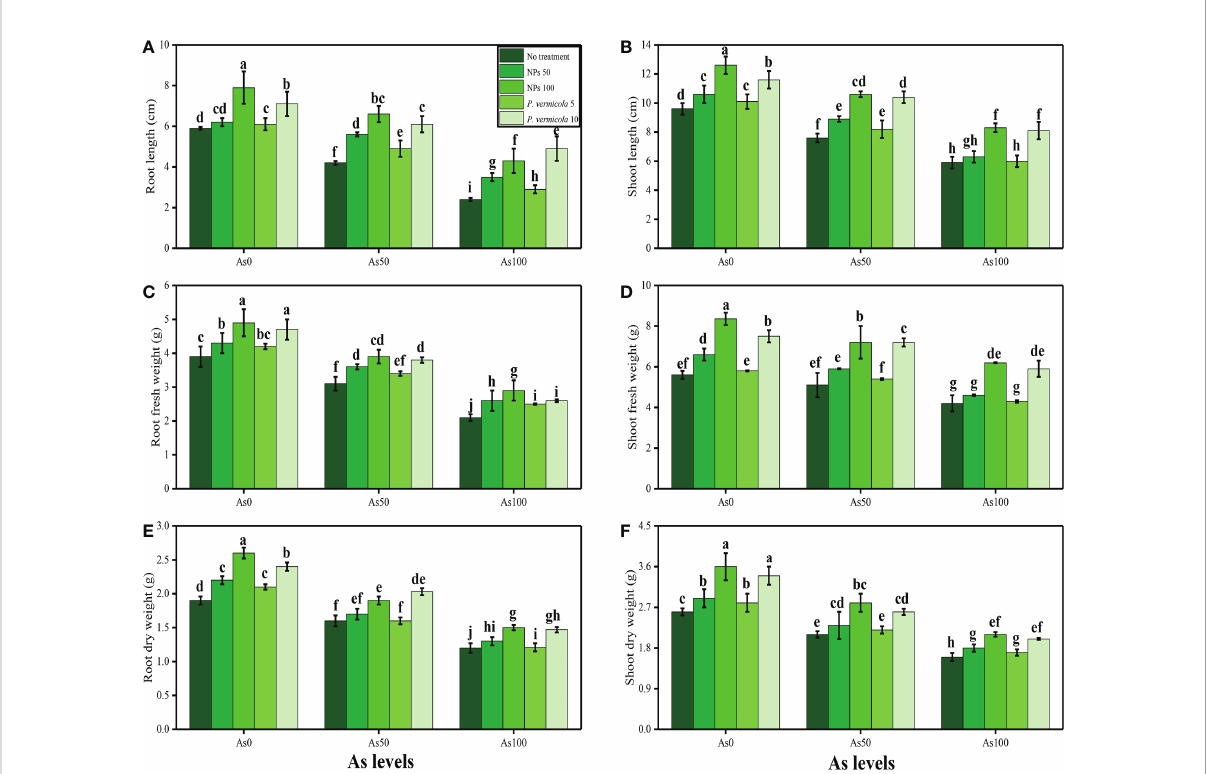
FIGURE 1 Effect of combined application of various levels of iron oxide nanoparticles (FeO-NPs) (i.e., 50 mg/l − 1 and 100 mg/l − 1 ) and plant growth- promoting bacteria ( Providencia vermicola ) (i.e., 5 ppm and 10 ppm) on root length (A) , shoot length (B) , root fresh weight (C) , shoot fresh weight (D) , root dry weight (E) , and shoot dry weight (F) of Ajwain ( Trachyspermum ammi seedlings) grown under various stress levels of arsenic (i.e., 0 m M, 50 m M, and 100 m M). Values are demonstrated as means of four replicates, along with standard deviation (SD; n = 4). Two-way ANOVA was performed and means differences were tested by Tukey ’ s highly signi fi cant difference post-hoc test ( p < 0.05). Different lowercase letters on the error bars indicate signi fi cant difference between the